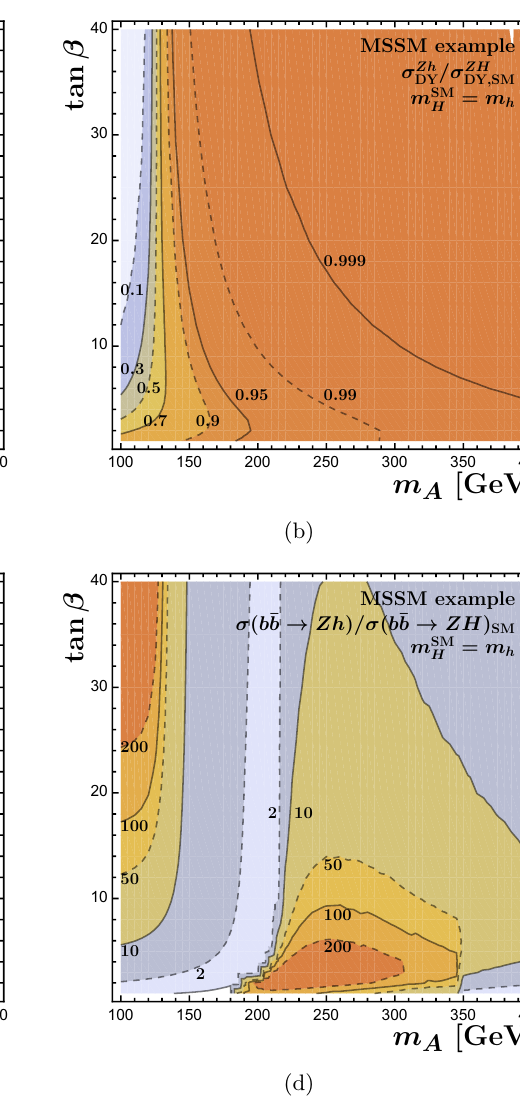
Figure 7 . Normalized production of a light Higgs boson in the MSSM as a function of m A in GeV and tan (cid:12) showing (a) the Higgs mass in GeV; (b) the DY -like cross section; (c) the gluon-induced cross section and (d) the bottom-quark initiated cross section. All cross sections are normalized to the SM Higgs cross section obtained for the same Higgs